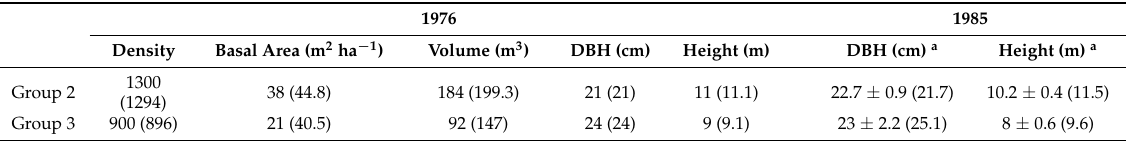
Table A2. Calibration results for TRIPLEX-Insect model using data from Cape Breton Island study sites. Values provided before the parentheses are published values from Ostaff and MacLean (1995) [36]. Values provided in the parentheses were simulated using the TRIPLEX-Insect model. The details about Group 2 and 3 were represented by Ostaff and MacLean (1989 and 1995)